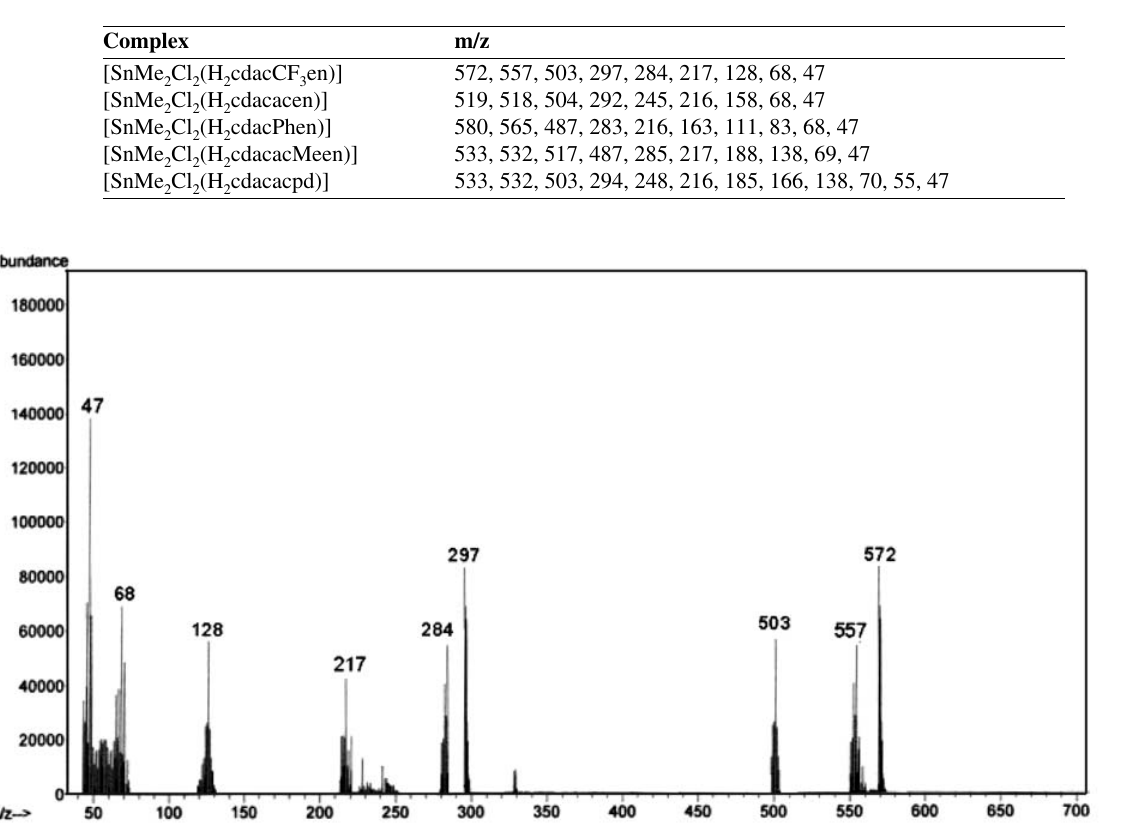
Cl (H cdacCF 2 2 2